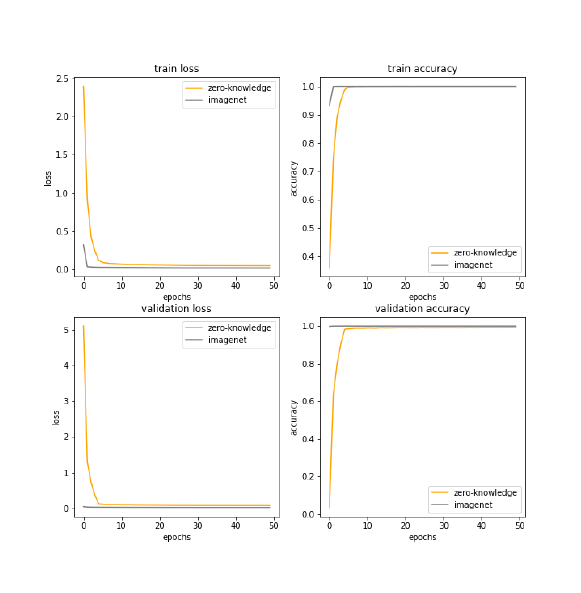
Figure 5. Comparison between a warm-up 50 epochs of the model initialized by the ImageNet and random weight.